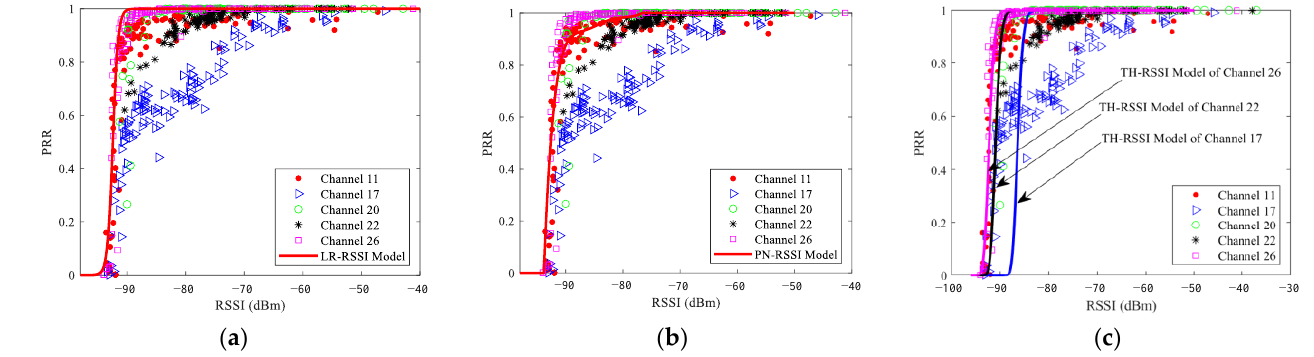
Figure 5. Measured and Estimated RSSI and PRR under different channels: ( a ) The LR-RSSI model; ( b ) The PN-RSSI model; ( c ) The TH-RSSI model.